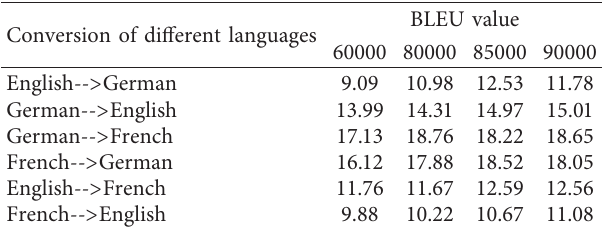
Table 1: Comparison of experimental results of different vocab- ulary